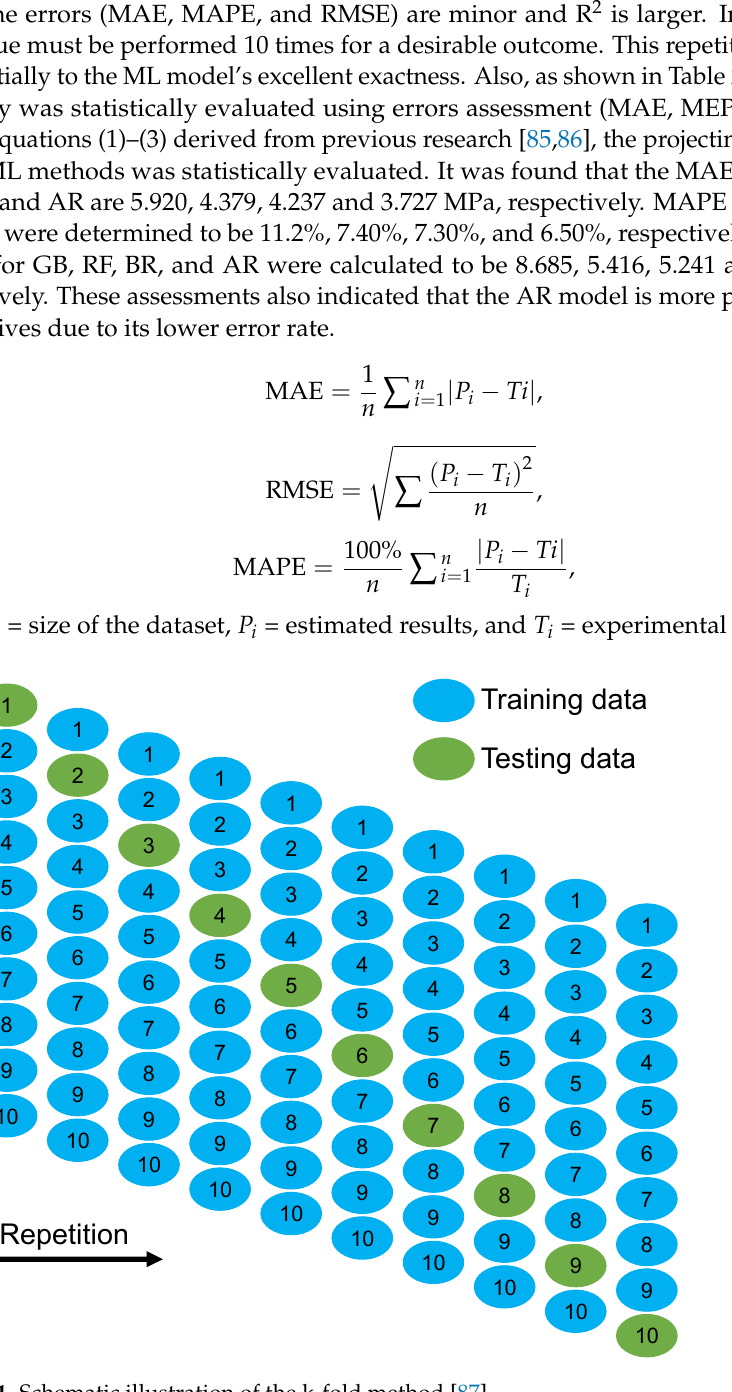
Figure 11. Schematic illustration of the k-fold method [87] .